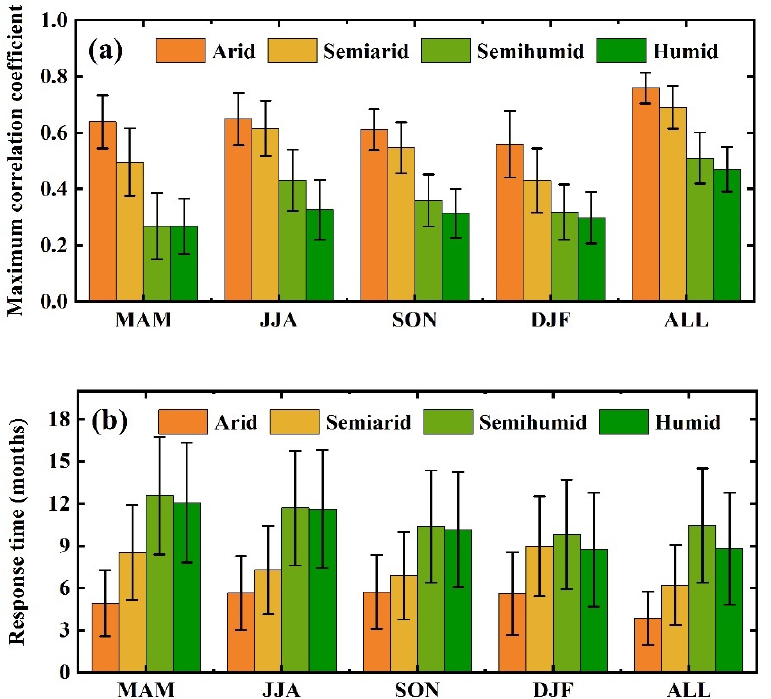
Figure 5. The correlation coefficient ( a ) and response time ( b ) of vegetation productivity to water availability in various climatic regions and different seasons. MAM, JJA, SON, DJF, and ALL represent March–May, June–August, September–November, December–February and the entire year, respectively. The error bars indicate ±1 standard error.